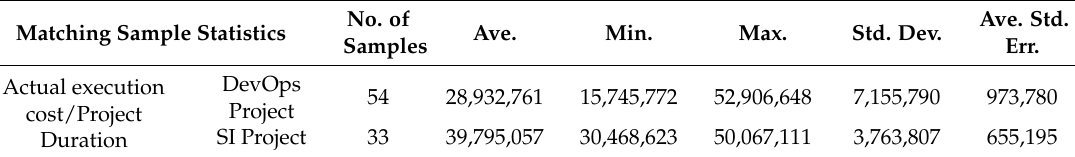
Table 11. Statistics of matching samples (project duration—execution cost).